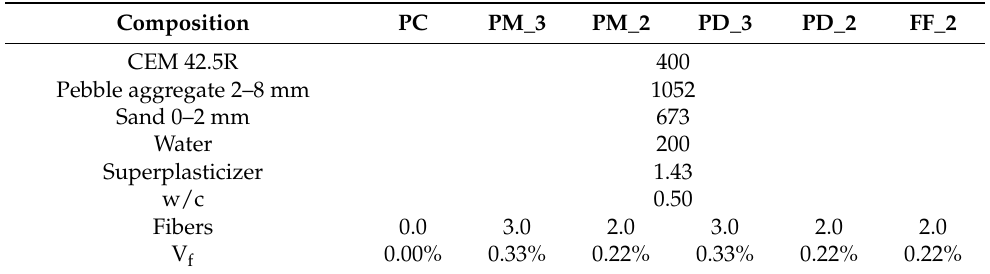
Table 3. Concrete mixture composition [kg/m 3 ].